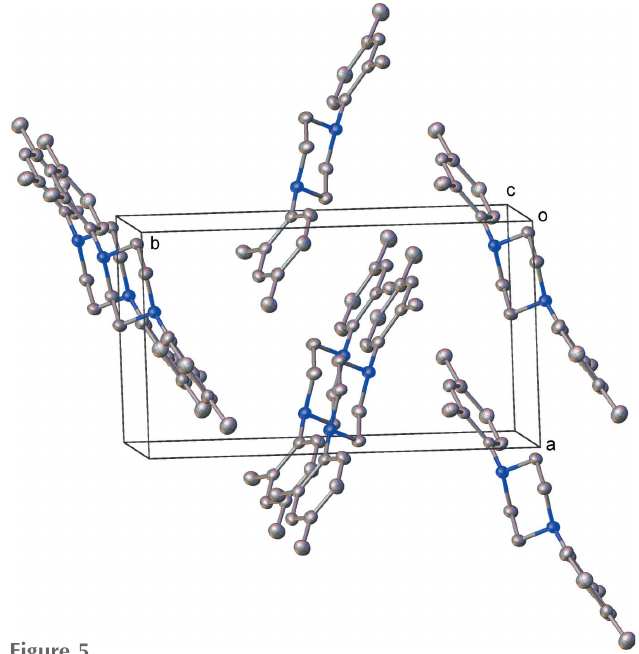
Figure 5 Packing diagram for compound 2 . Hydrogen atoms are omitted for clarity.